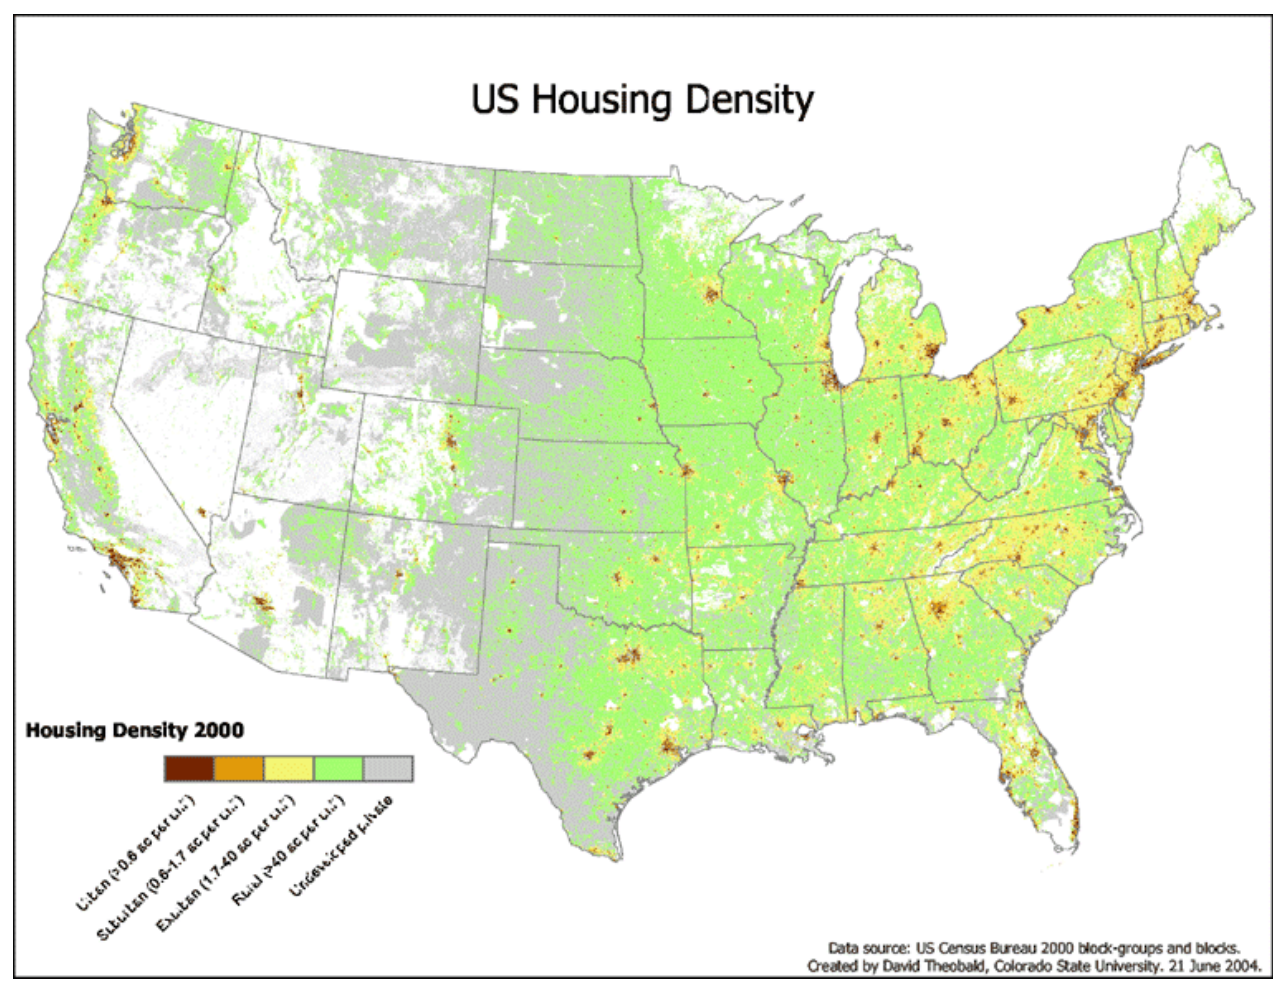
Fig. 7. A high-resolution map showing housing density classes for 2000.